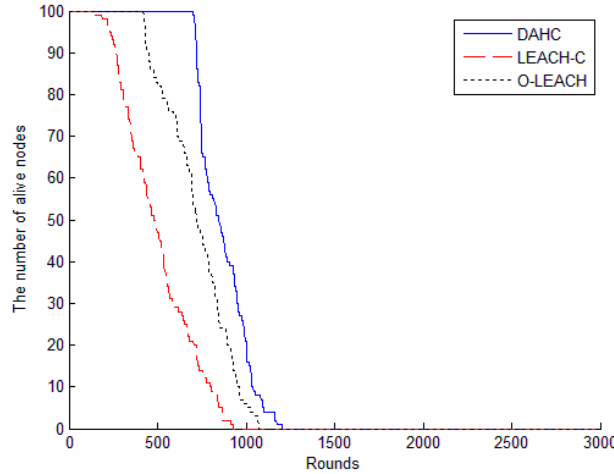
Figure 6. The number of alive nodes versus rounds when the BS is outside.